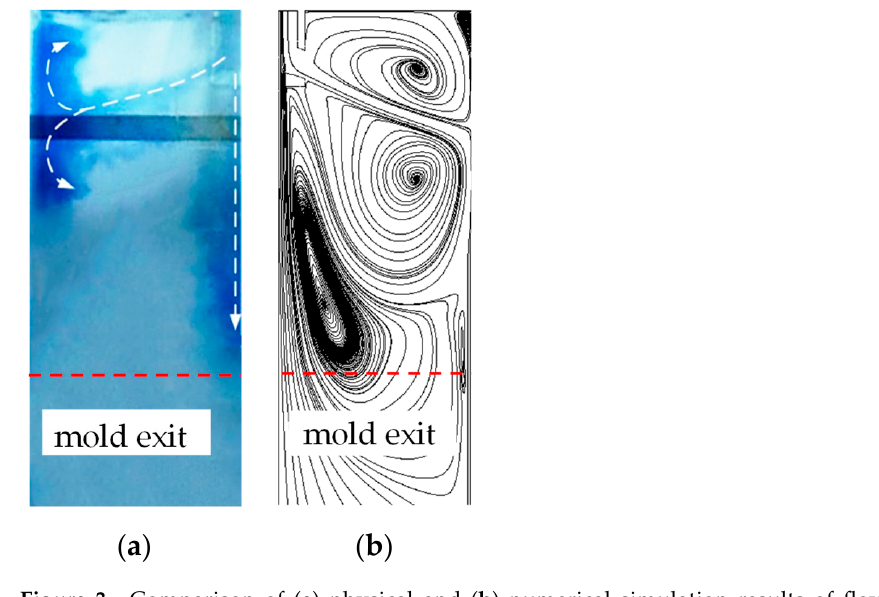
Figure 3. Comparison of ( a ) physical and ( b ) numerical simulation results of flow pattern in the model.